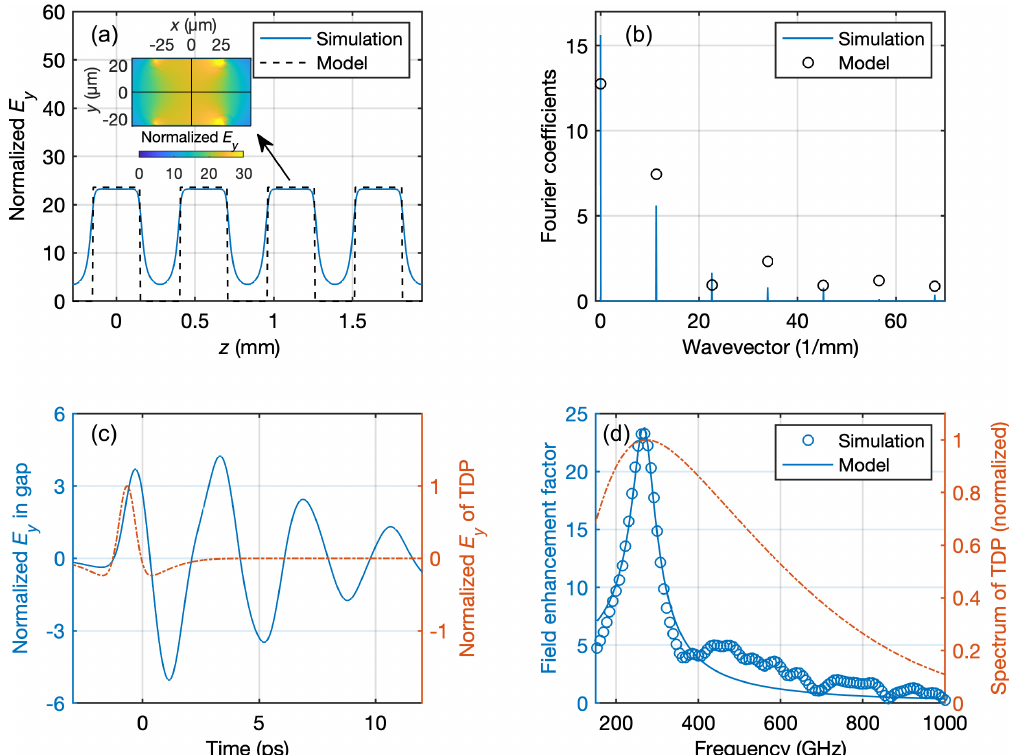
FIG. 2. (a) Simulated y -component of the electric field at the middle of the SRR gap as a function of the longitudinal position. The field is normalized to the electric field strength of the TDP and the time is fixed for the maximum field strength. The SRR thickness s is 300 μ m and distance d is 555 μ m. The black dashed curve corresponds to the assumption used in the analytic model Eq. (5). The inset shows the y -component of the electric field in a xy -slice at the longitudinal position of the gap middle. (b) Fourier spectrum of the longitudinally varying electric field together with the Fourier components from the analytic model Eq. (6). (c) Simulated time-dependent field inside the SRR gap exited by a specific TDP. (d) Spectrum of the TDP and the frequency dependent enhancement factor. The solid curve corresponds to a fit based on Eq.